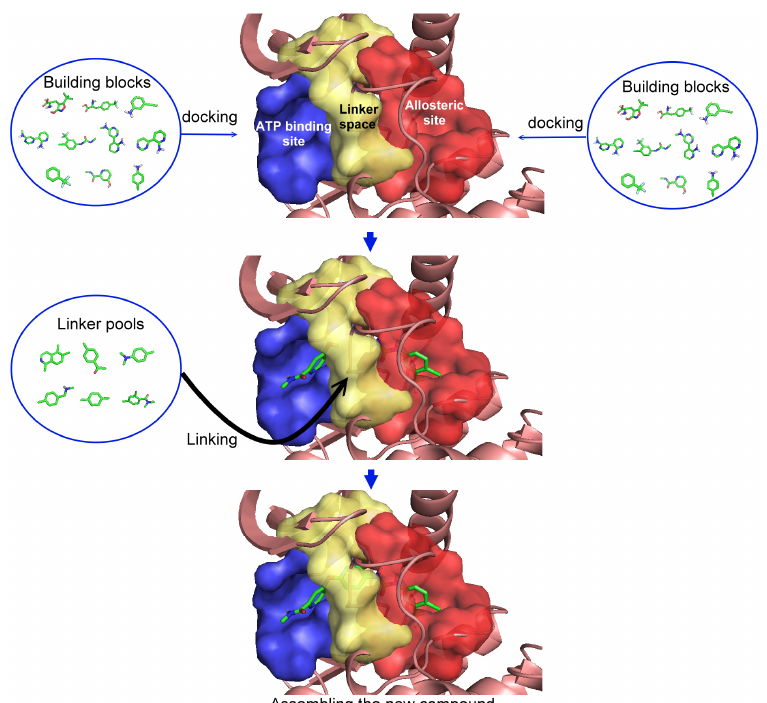
Figure 1. Illustration of the first three steps to generate new compounds based on template